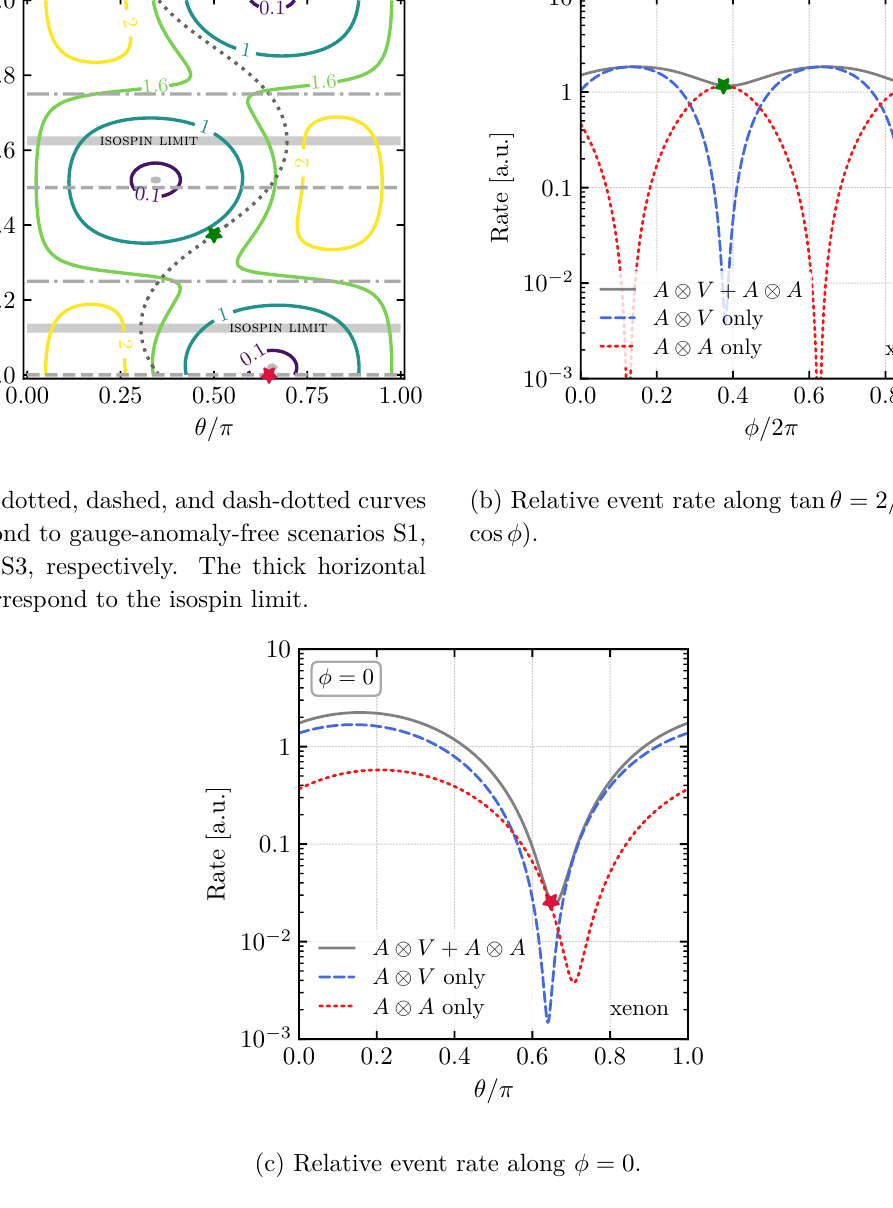
Figure 2. The direct-detection rate for m χ = 100 GeV using the parameterisation of eq. (2.6) with normalisation corresponding to the overall size of the Wilson coefficients. The green (red) star shows the benchmark point BM3 (BM4)in table 2. The solid grey curve in upper right and lower panels shows the combined relative rate with the normalisation of panel ((a)) along φ = 0 , while the dashed (blue) and dotted (red) curves show the sole A ⊗ V and A ⊗ A contributions along the same curve,